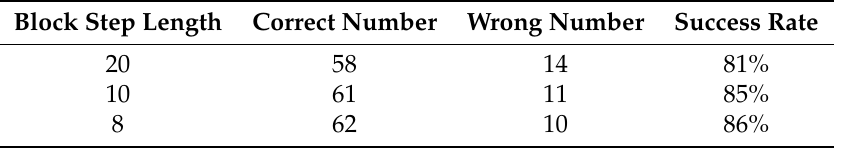
Table 3. Block step length test